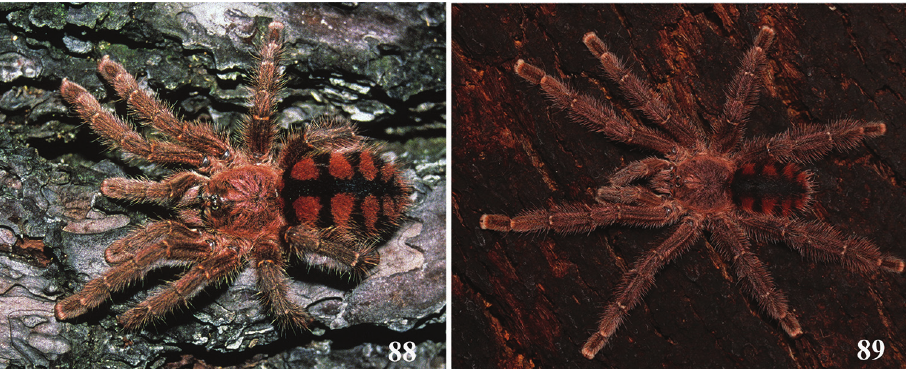
89 male. Photos: 88 J. Huff; 89 J. Newland.